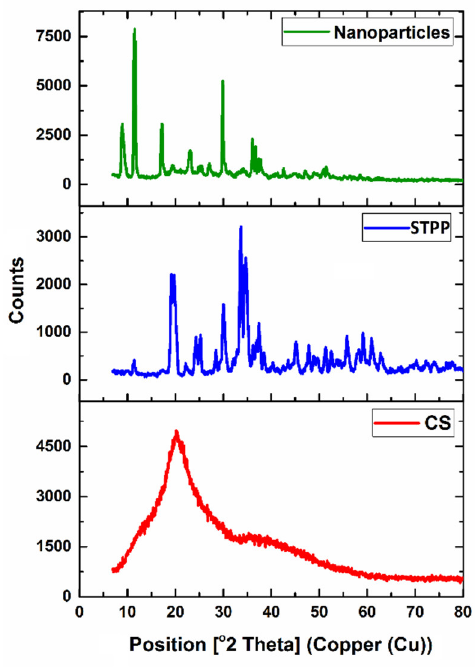
Figure 7. The XRD patterns of chitosan (CS), sodium tripolyphosphate (STPP), and CS nanoparticles (CSNPs).